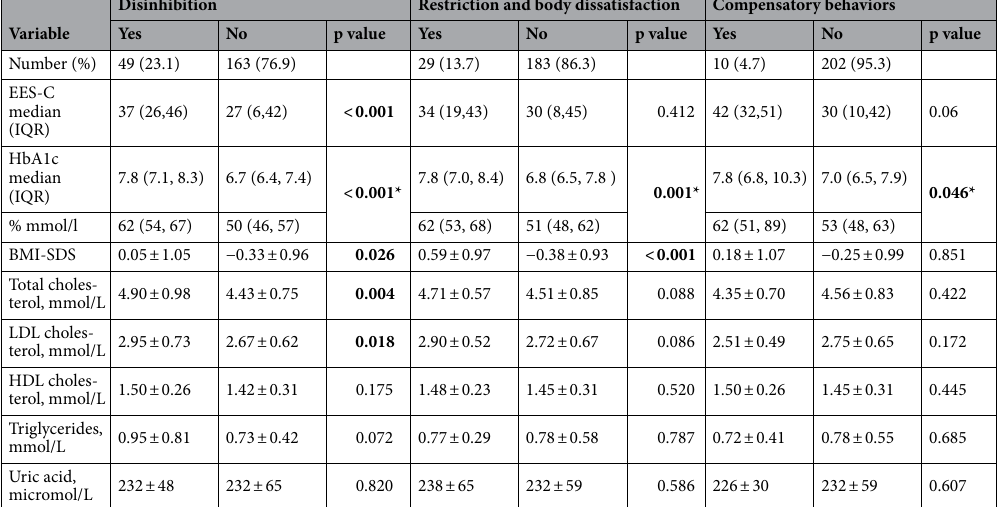
Table 4. Comparison between subjects with or without symptoms of eating disorders. Data are expressed as mean and standard deviation unless otherwise specified. For comparisons between groups two-tailed t-test was used. IQR inter quartile range, EES-C emotional eating scale for children and adolescents, BMI-SDS body mass index-standard deviation score, HbA1c glycated hemoglobin, LDL low density lipoprotein, HDL high density lipoprotein. *Mann–Whitney test. Significant values are in